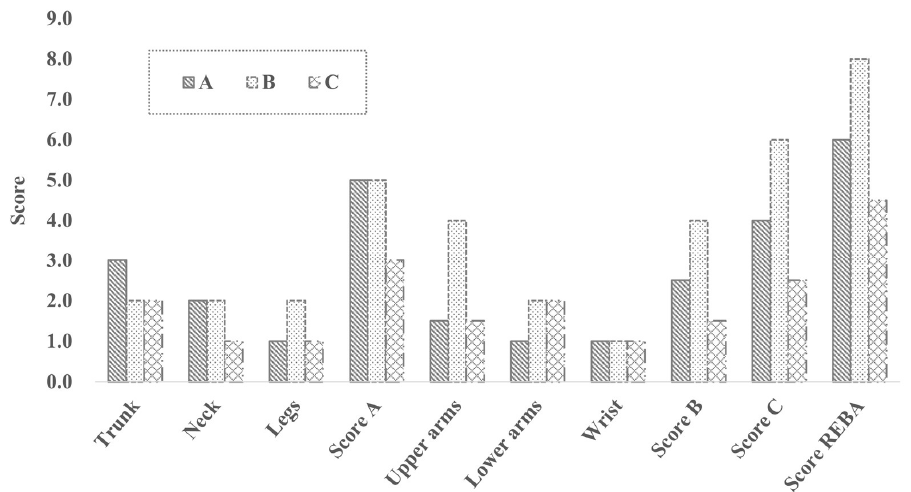
Figure 26. Precision evaluation results of planer working posture.